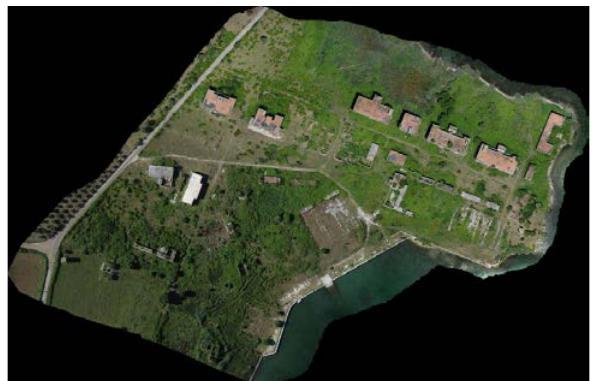
Figure 8. Orthophoto